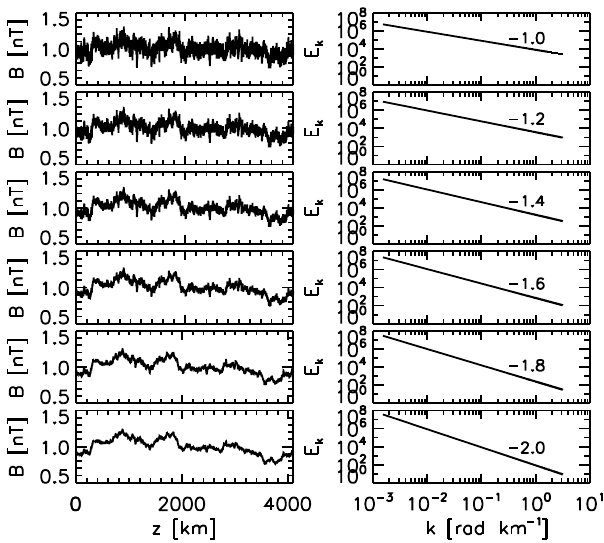
Figure 1. Synthetic data (left panels) and the energy spectra used to generate the synthetic data (right panels).